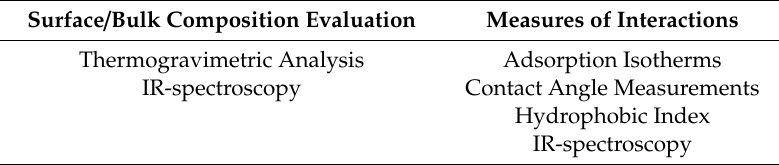
Table 5. Methods of hydrophobic properties